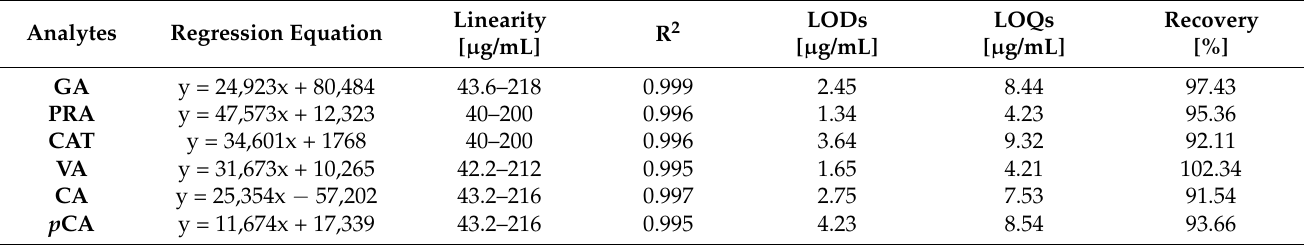
Table A1. Parameters of calibrations for the phenolics standards